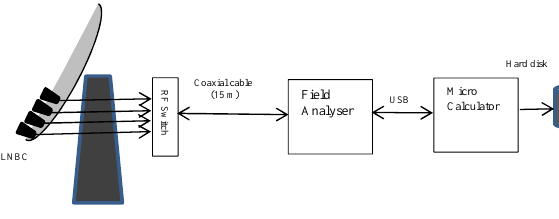
Fig. 3. Experimental